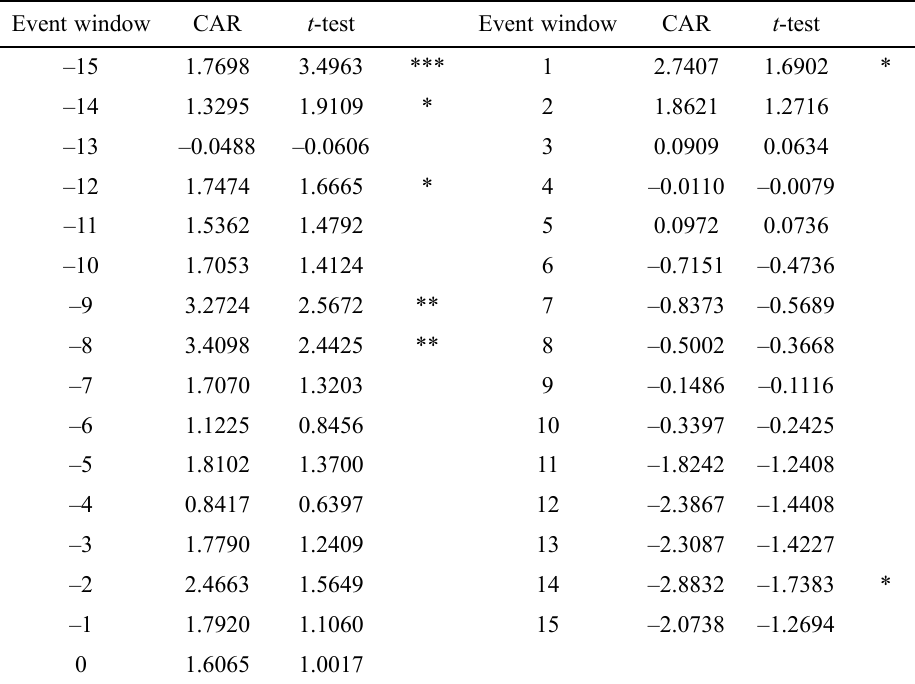
Table 4. CAR of pharmaceutical during the period of infectious